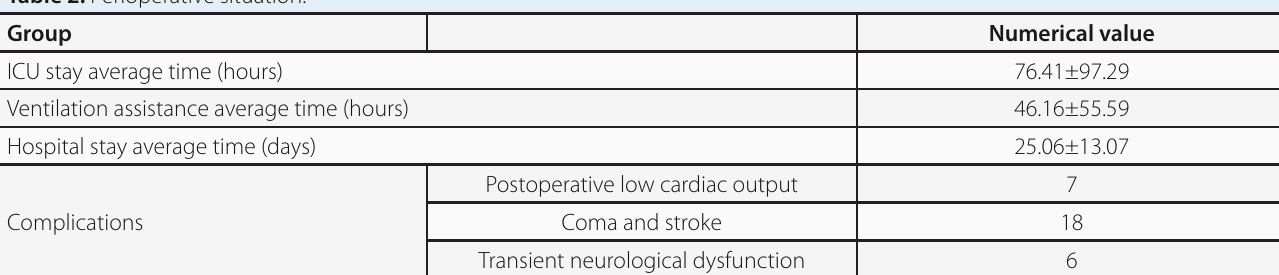
Fig. 1 - Postoperative negative outcomes.